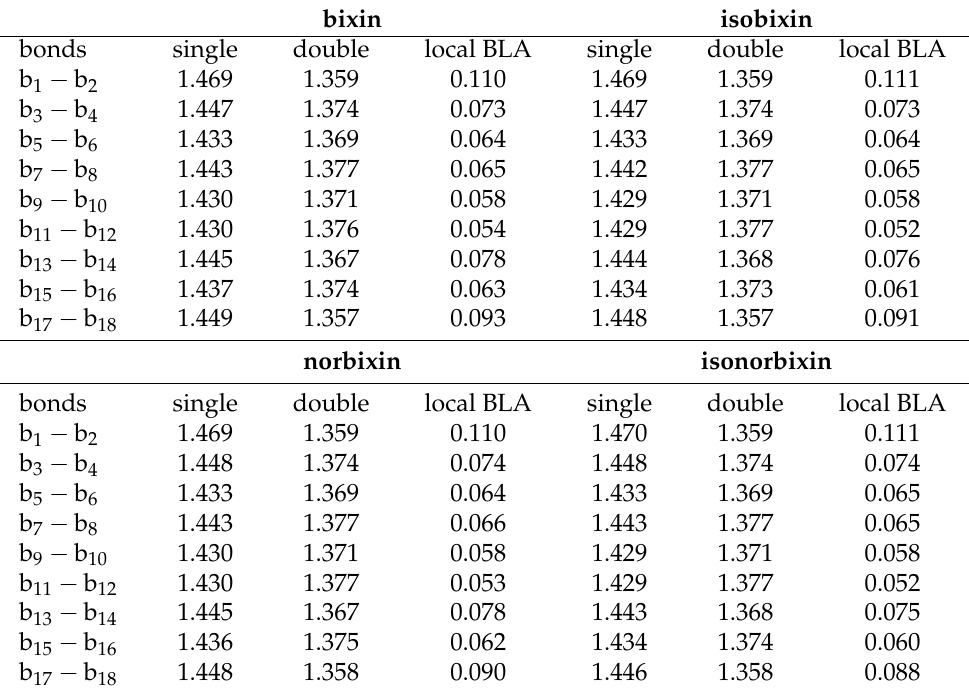
Table A4. Single-double bonds and local BLA values (Å) of the molecular dyes in chloroform solution. These results were obtained by employing the B3LYP/6-31+G(d,p) level of theory.